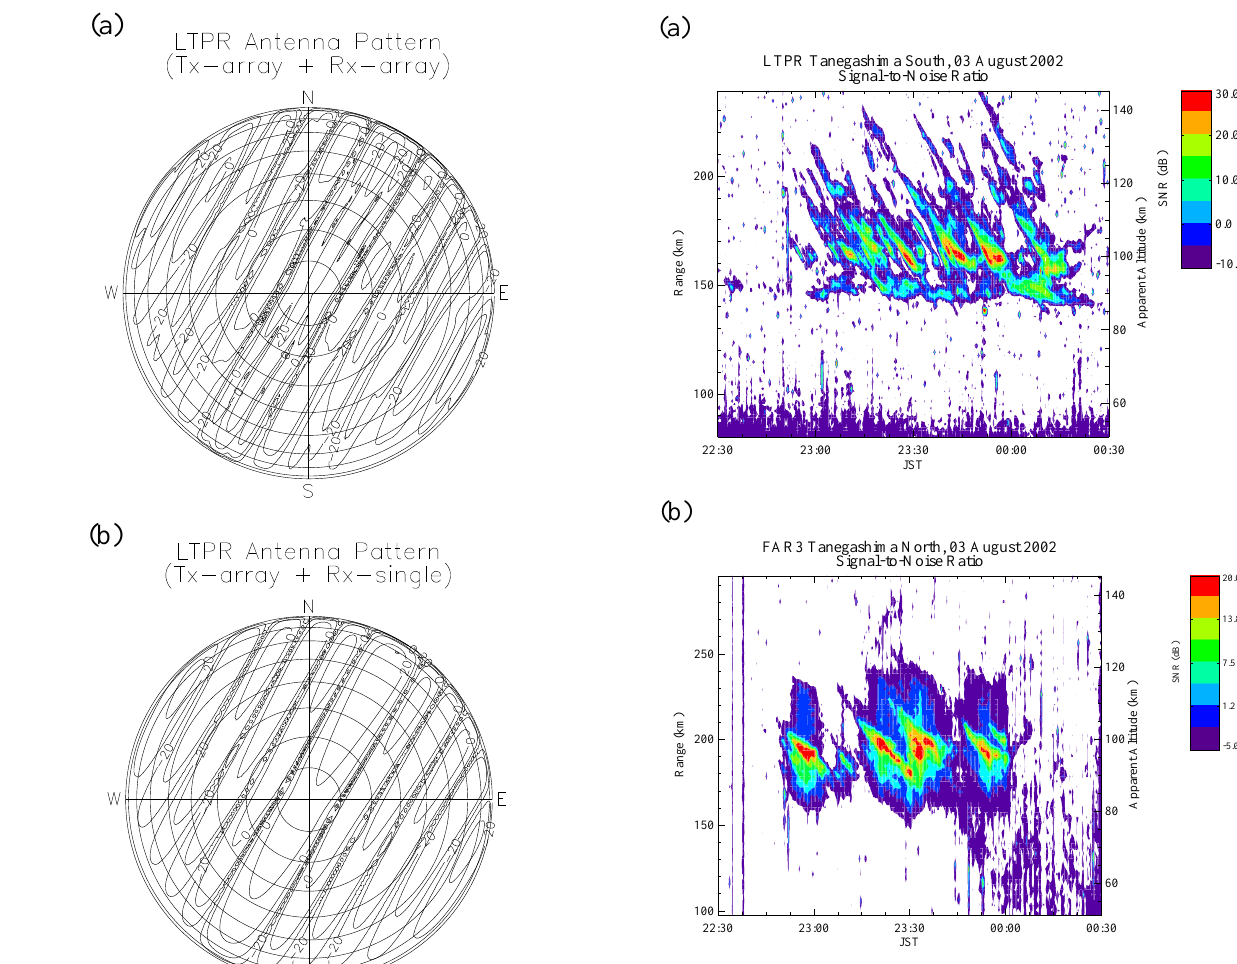
Fig. 4. Range-Time-Intensity plots of echo power observed by (a) LTPR and (b) FAR from 2230 JST 3 August to 0030 JST 4 Au- gust 2002. The left vertical axes show the ranges of echoes, while the right axes show the “apparent altitudes” which are calculated from the range and the perpendicularity condition assuming that the azimuth of echoes are at the center of the radar beam (+30 ◦